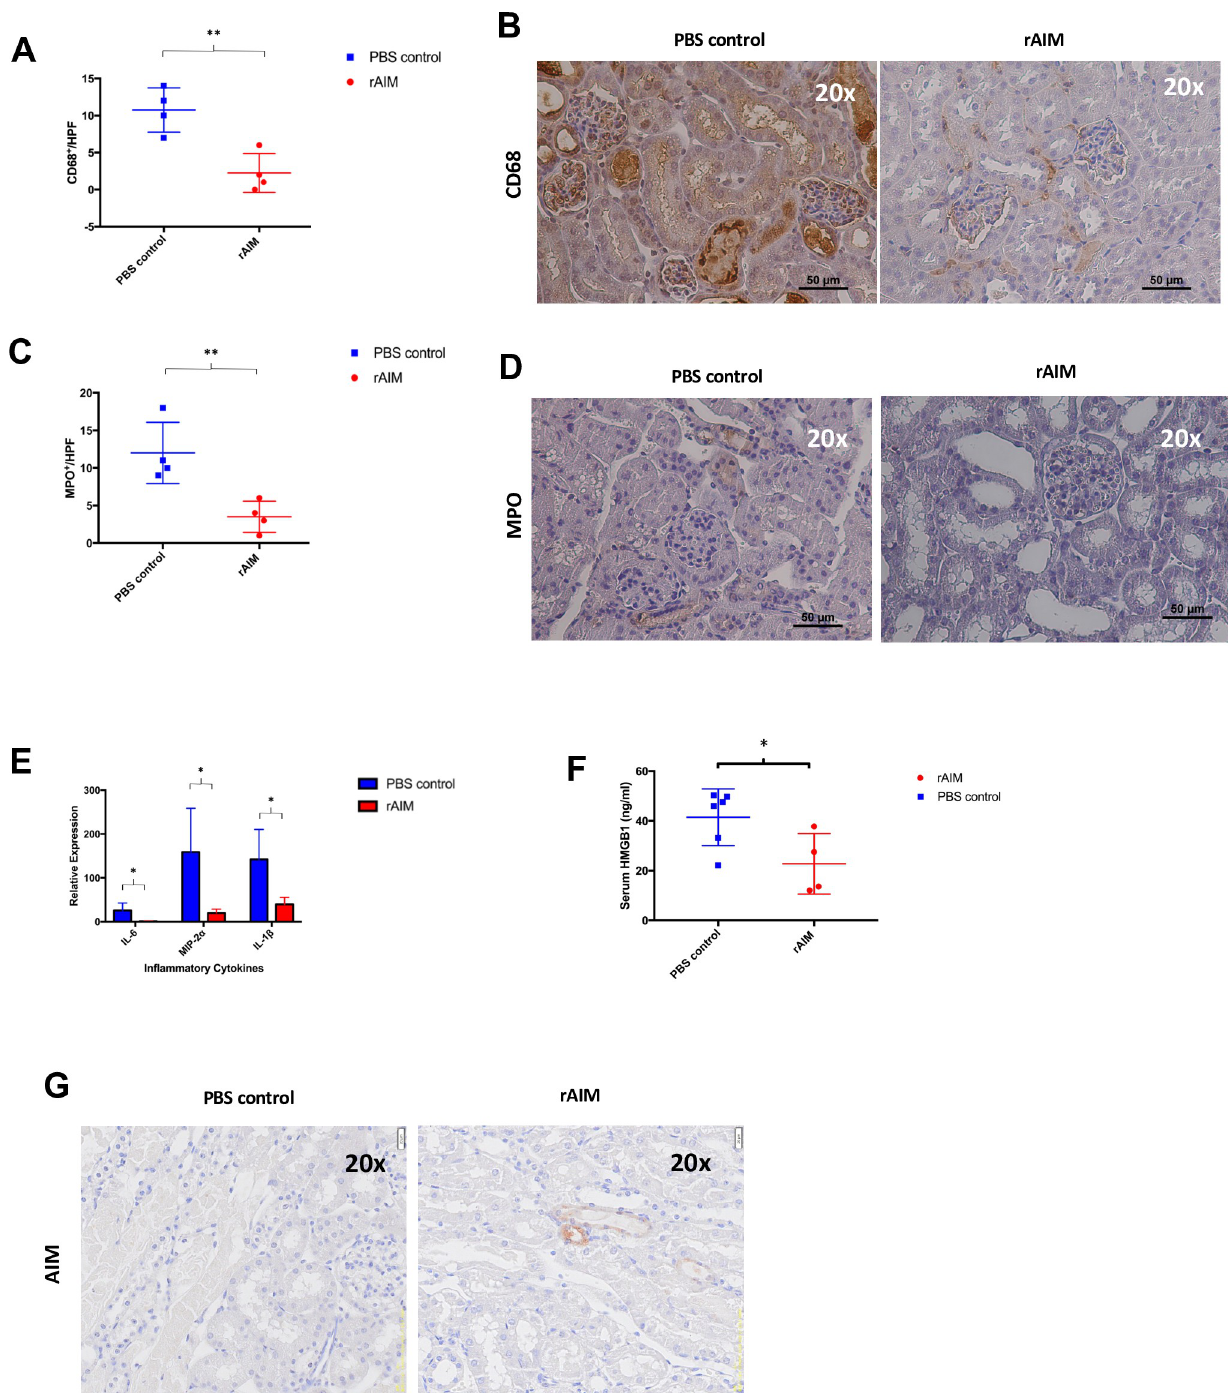
Fig 2. Recombinant AIM administration alleviates local tissue and systemic inflammation following syngeneic renal transplantation. (A-D) Kidney tissue sections were stained for CD68 or MPO to detect graft-infiltrating macrophages and granulocytes, respectively. (A) Number of CD68 + macrophages/HPF. (B) Immunohistochemistry images of kidney graft sections staining CD68. (C) Number of MPO+ granulocytes/HPF. (D) Immunohistochemistry images of kidney graft sections staining MPO. (E) Measurement of pro-inflammatory cytokines (IL-6, MIP-2 ɑ , and IL-1 β ) using quantitative RT-PCR. Data were normalized to GAPDH gene expression. � p < 0.05, �� p < 0.01, n = 4/group. (F) Serum HMGB1 levels were quantified using ELISA. p = 0.1, n = 4-6/group. (G) Kidney tissue sections were stained for AIM.